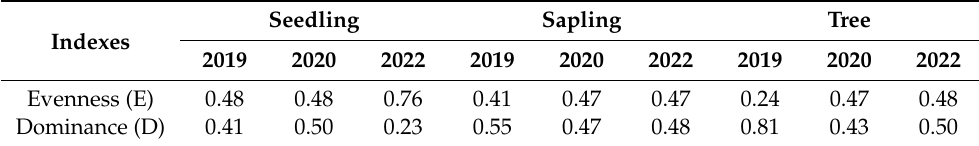
Table 10. Index of evenness and dominance of vegetation planting with seedlings. Seedling Sapling Indexes